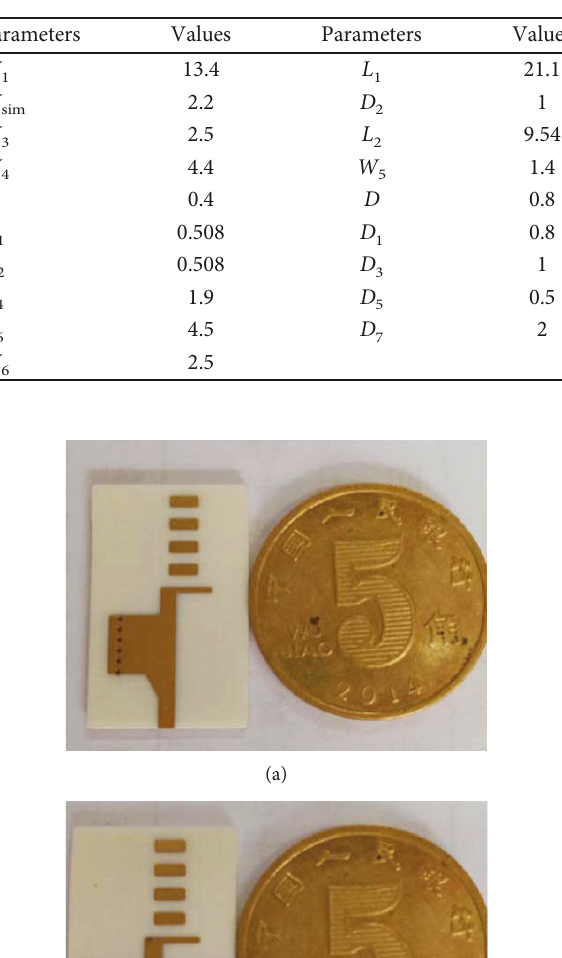
Table 2: Values of the geometry parameters for the proposed Yagi antenna (all units in millimeters).